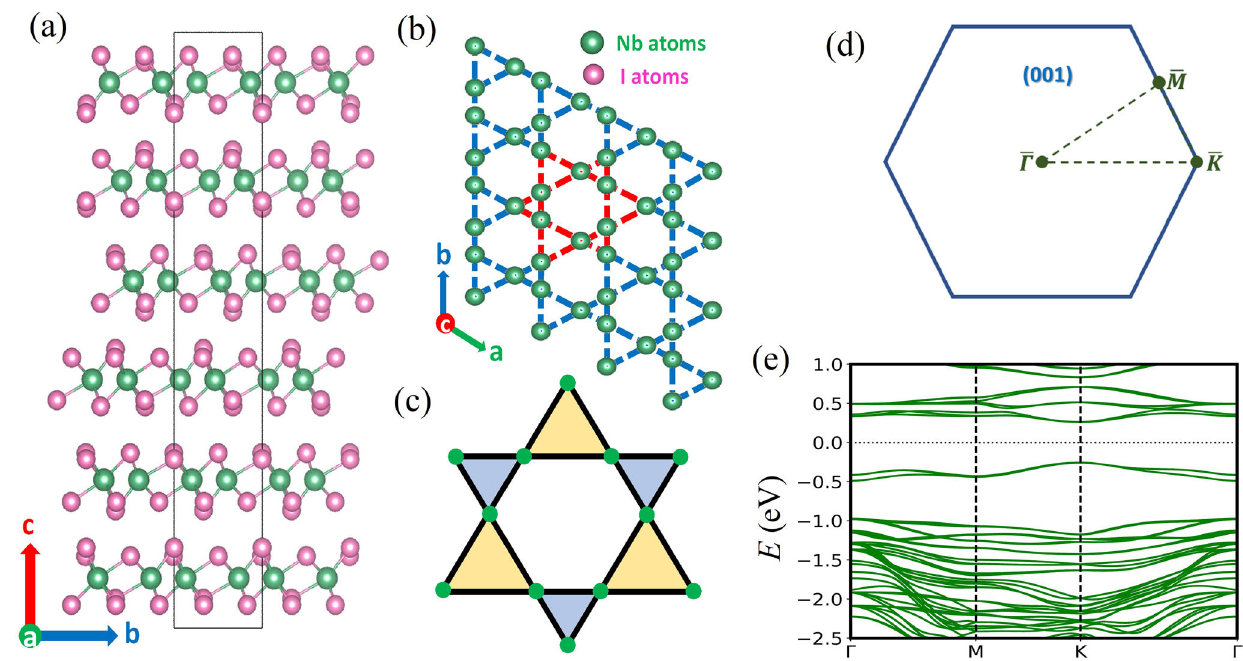
Fig. 1 Crystal structure and bulk band calculation of Nb 3 I 8 . a Crystal structure of Nb 3 I 8 , where the green and magenta spheres represent Nb and I atoms, respectively. b Nb atoms forming a breathing kagome lattice. A schematic of the breathing kagome lattice is presented in ( c ). The alternating triangles are not identical giving rise to a breathing lattice. d Projected hexagonal BZ on the (001) surface showing the high-symmetry points and directions. e Calculated band structure for bulk Nb 3 I 8 .